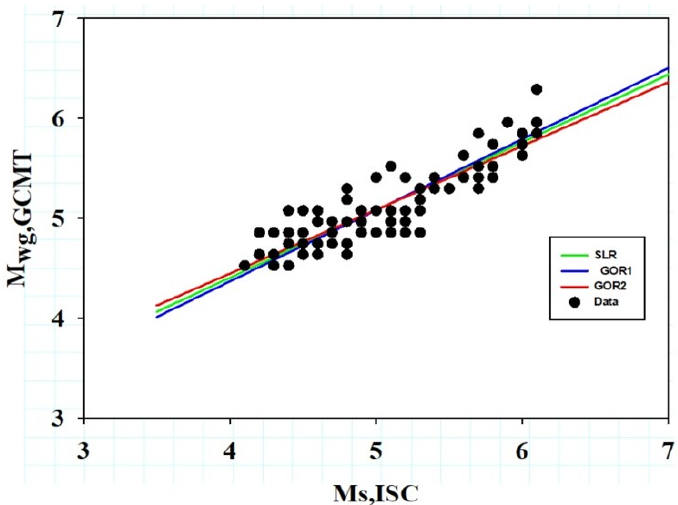
Figure 3. The (M S,ISC − Mwg) data, as well as the GOR1, GOR2, and SLR regression lines. Table 2. Comparisons of regression parameters of GOR1, GOR2 and SLR for Northeast India Region